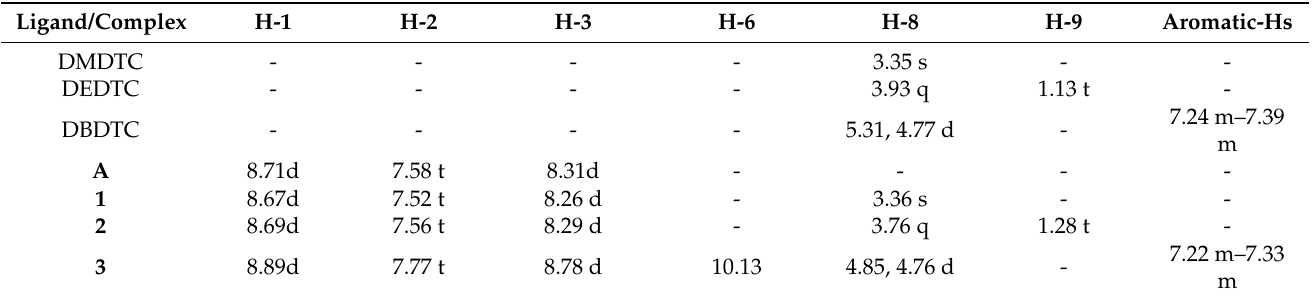
Table 2. 1 H-NMR chemical shifts for free ligands and their compounds in DMSO- d 6 .